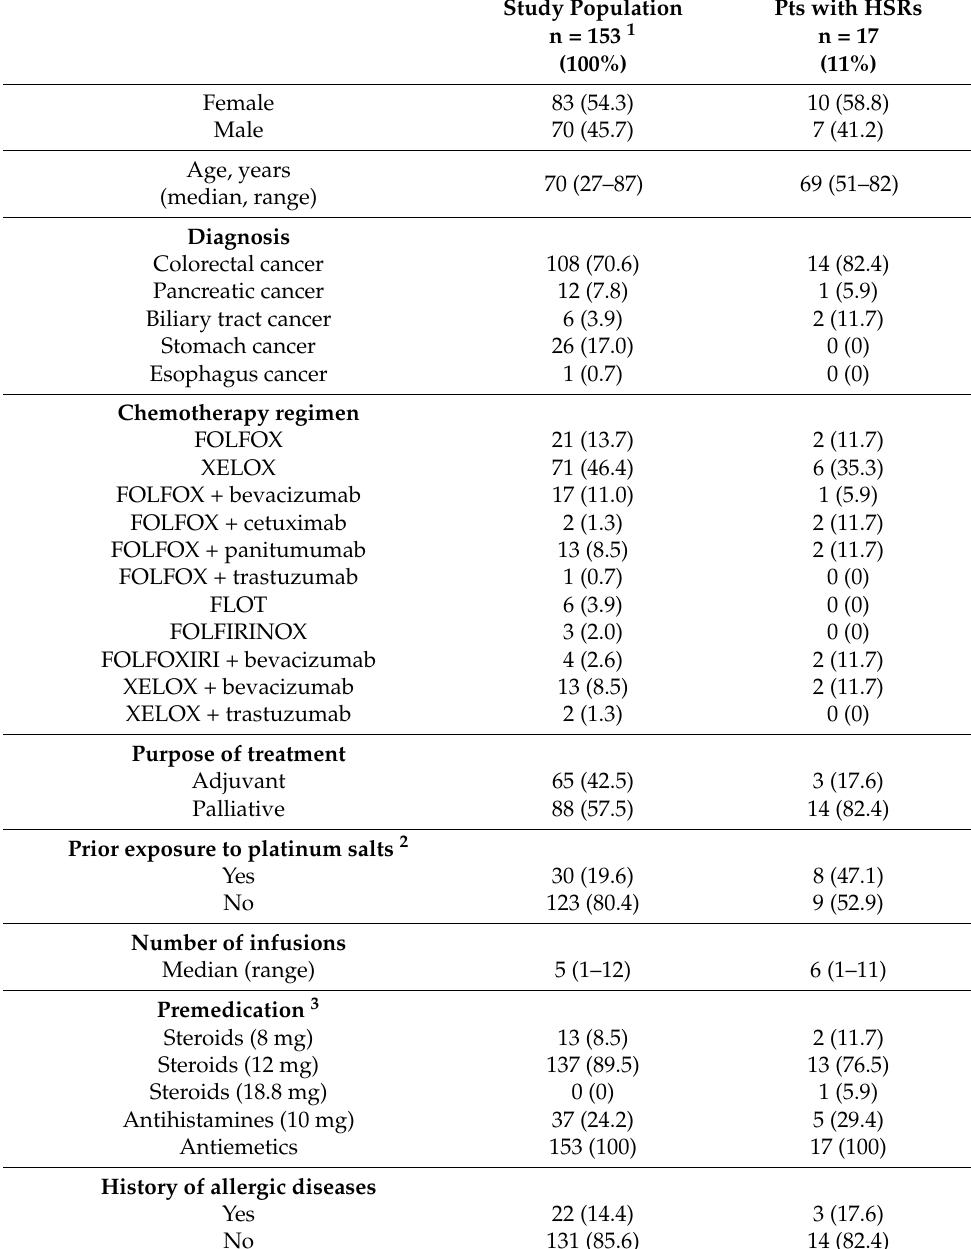
Table 1. Demographic and baseline characteristics of